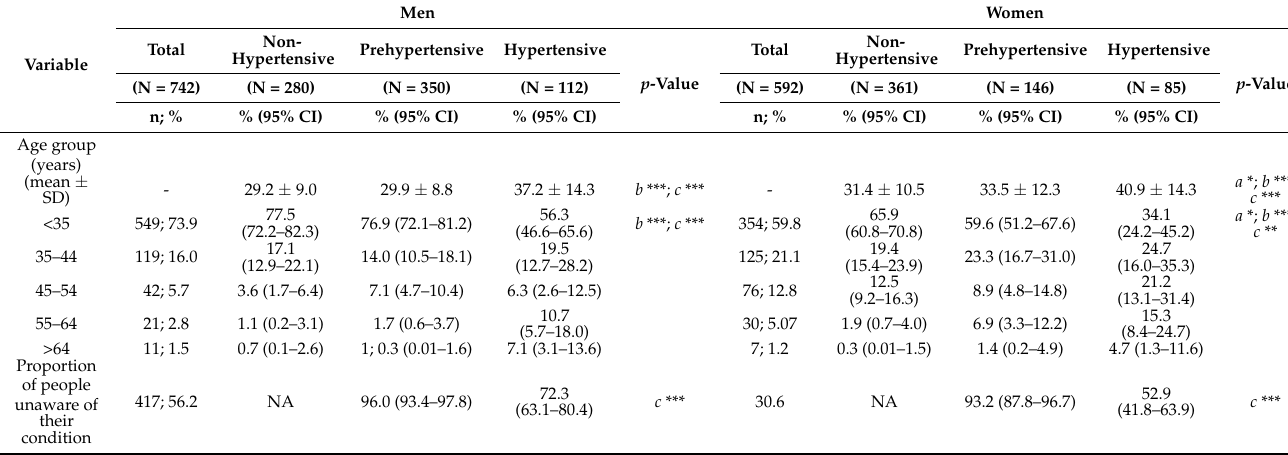
Table 1. Mean and age groups of participating men and women according to their BP